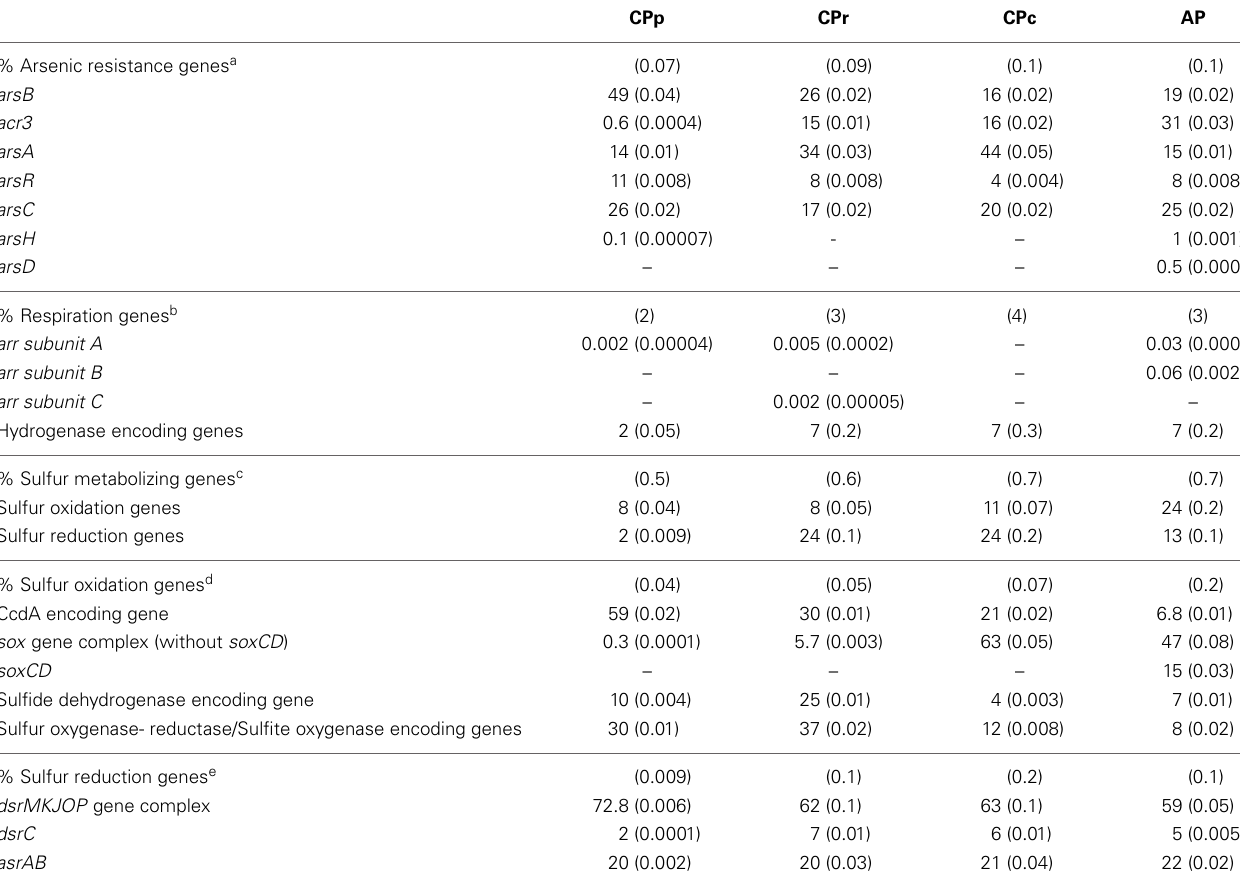
Table 4 | Arsenic and sulfur genes found in the metagenome of Champagne Pool